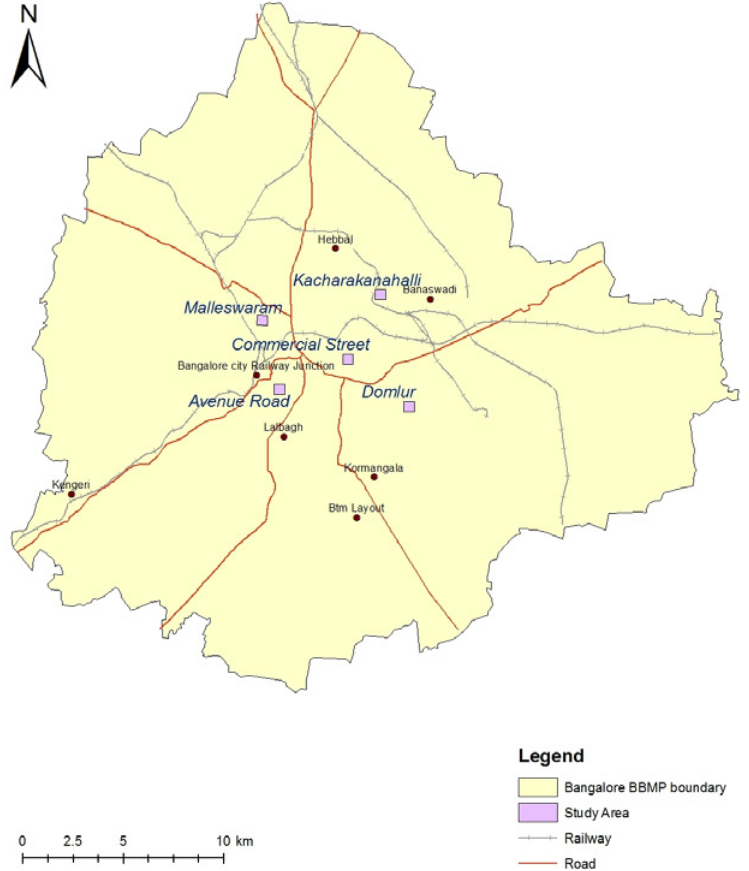
Figure 1. Location of five study areas in Bangalore, representing different time points in the history of urban expansion of the